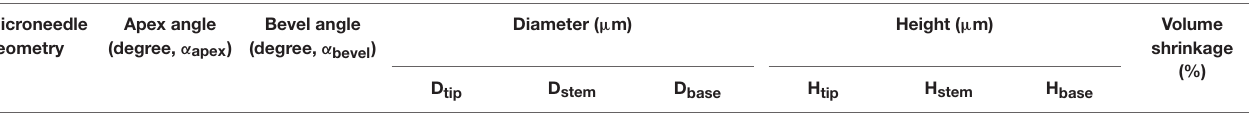
TABLE 3 | Measured dimensions of PVP microneedles (mean ± standard deviation, n = 7). Microneedle Apex angle Bevel angle Diameter ( µ m) Height ( µ m) Volume geometry (degree, α apex ) (degree, α bevel ) D tip D stem D base H tip H stem H base Circular obelisk Beveled-